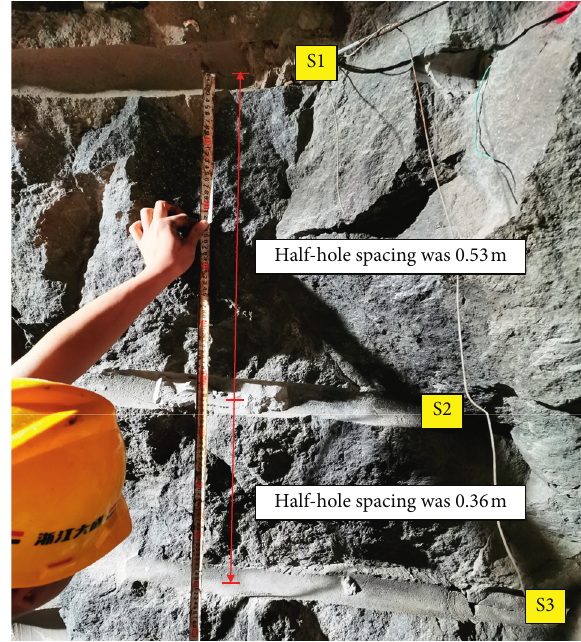
Figure 10: Initial rock fracturing effect on side